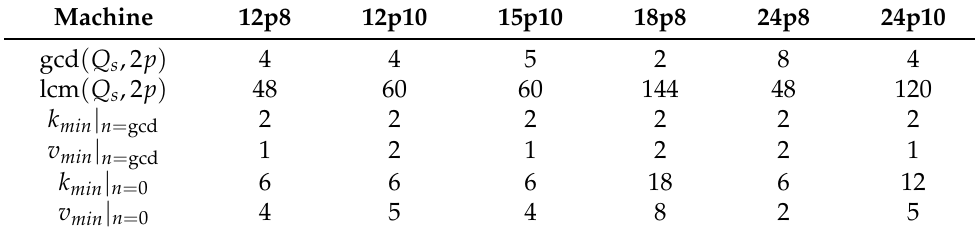
Table 7. Parameters of the machines of 8 and 10 pole pairs.